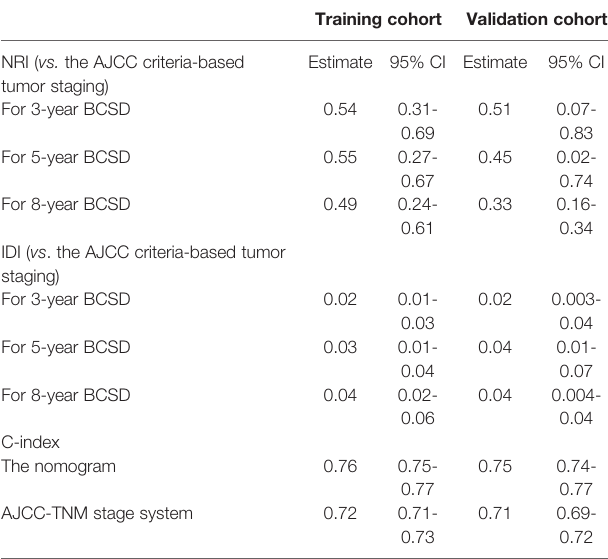
TABLE 5 | C-index, NRI, and IDI of the nomogram and AJCC-TNM stage system in BCSD prediction for MaBC patients.